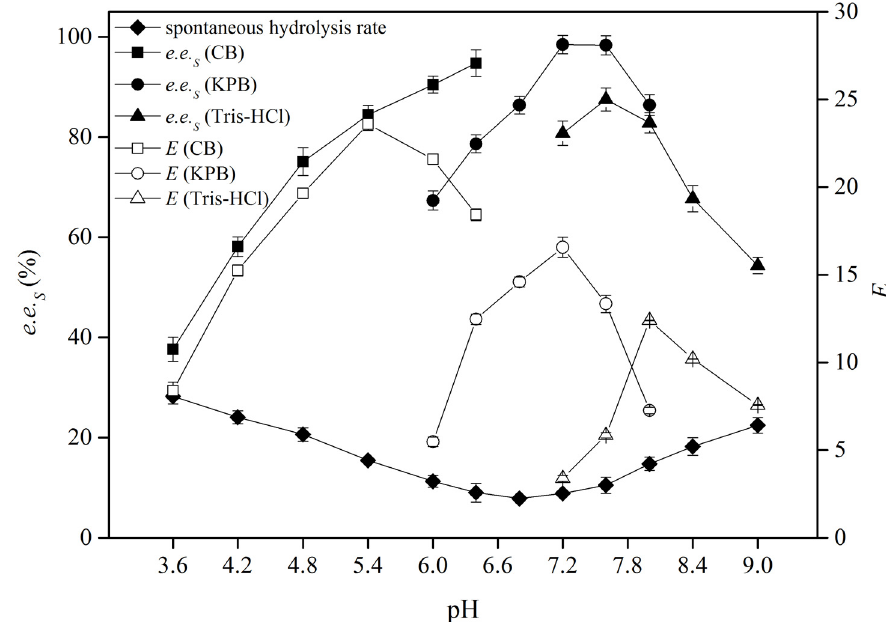
Figure 3. Effects of buffer types and buffer pH on the resolution of rac -EPG by G. geotrichum ZJUTZQ200. Reaction conditions: 1.0 g wet mycelium, 0.01 mL rac -EPG, 10 mL buffer, 30 °C, 200 rpm and 6